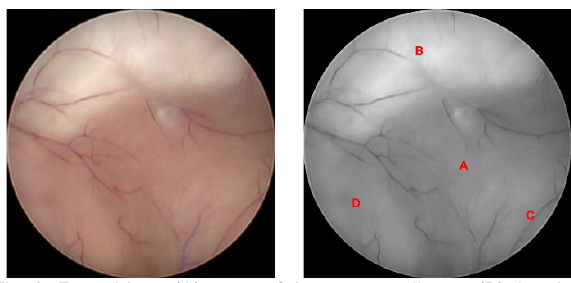
Fig. 8. Frontal horn (A), genu of the corpus callosum (B), head of the caudate nucleus (C), septum pellucidum